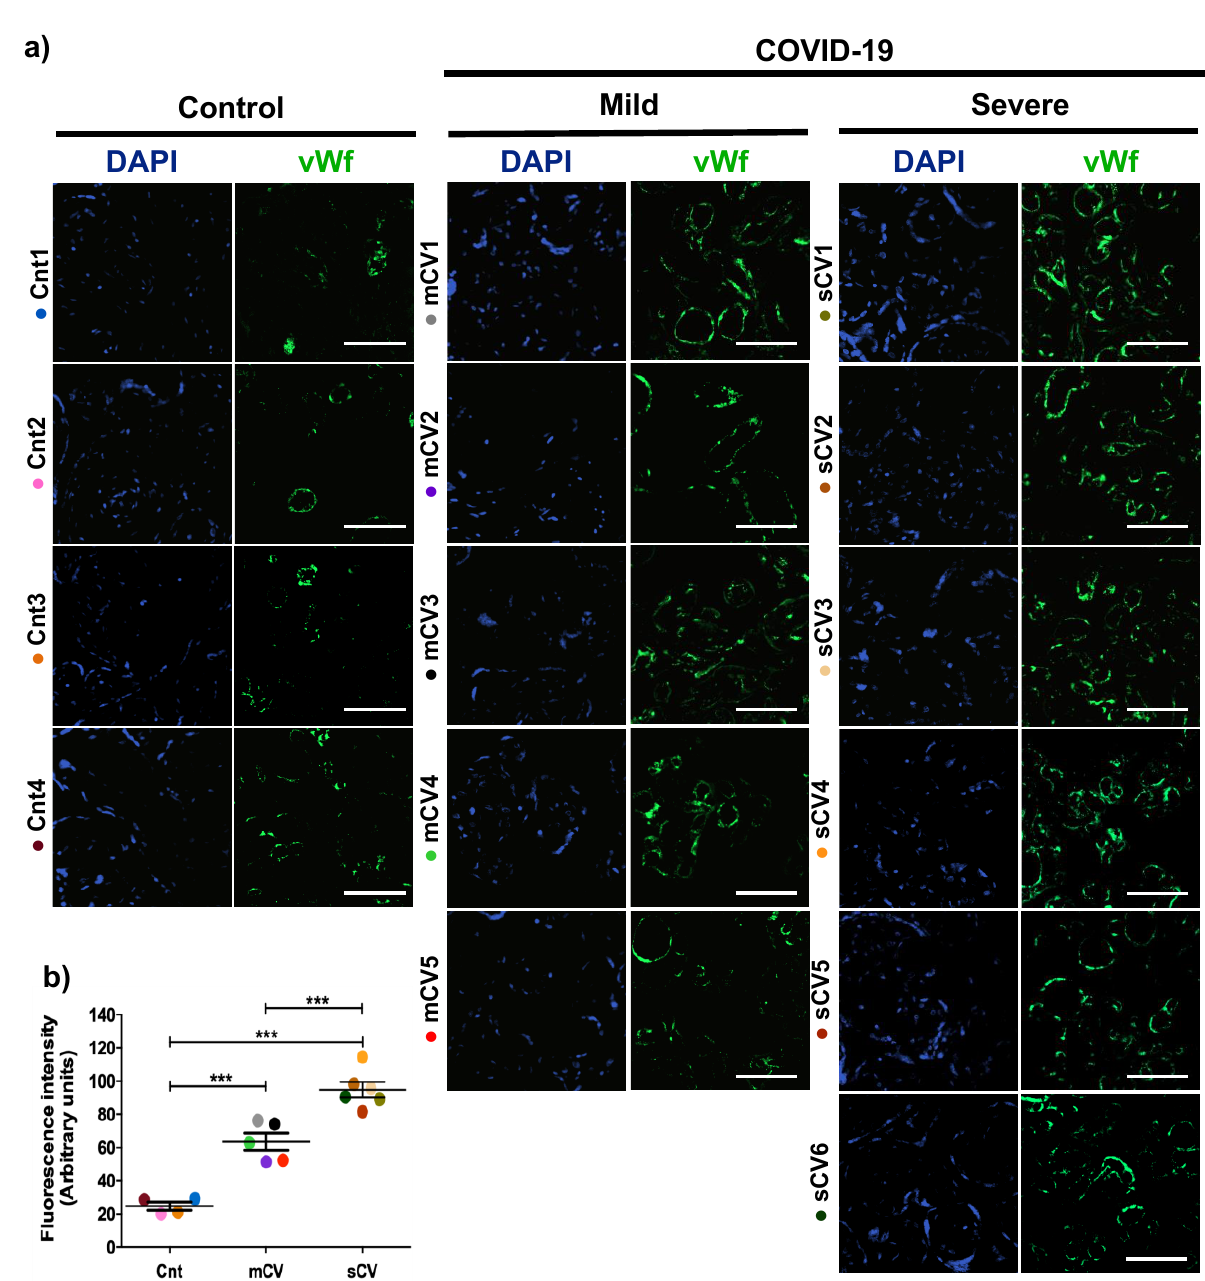
Figure 2. The expression of vWf increases in the endothelium of chorionic villi in placentas of women with COVID-19. Paraffin blocks of placentas derived from women with COVID-19 and controls were cut in 1 µ m slices, deparaffinized and processed for immunofluorescence with antibodies against vWf. ( a ) Representative images of vWf in chorionic villi. DNA of nuclei was stained with DAPI. Bar, 100 µ m. ( b ) Quantification of mean fluorescent intensity done on three independent images from each condition. Data are expressed as mean ± SD; F ANOVA test followed by Duncan’s multiple comparison test, *** p < 0.001. Cnt, control; mCV, mild COVID-19; sCV, severe COVID-19.